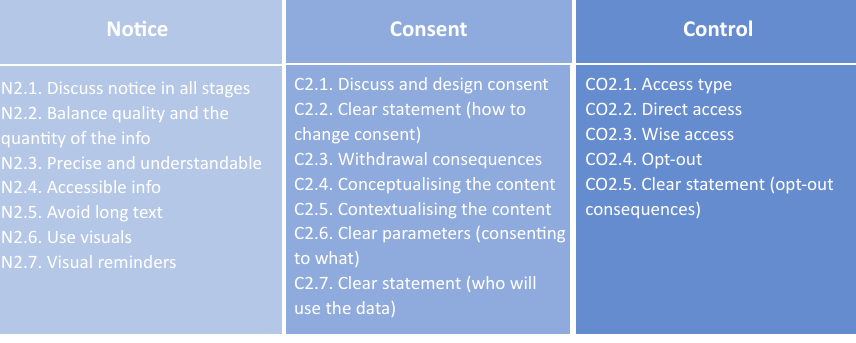
Figure 2. Recommended guidelines based on legal requirements and expert